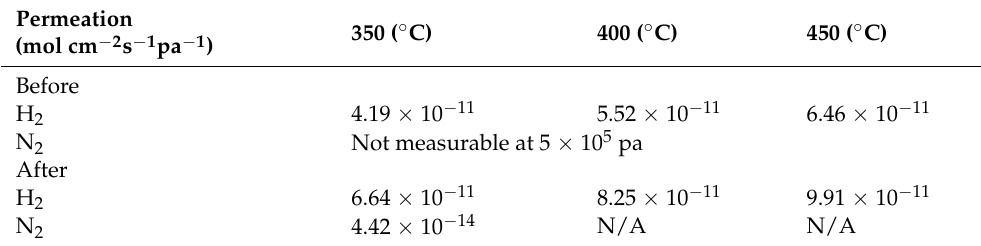
Table 10. Hydrogen permeating through Pd membrane before and after ammonia decomposing at different temperatures. Reprinted with permission [36].